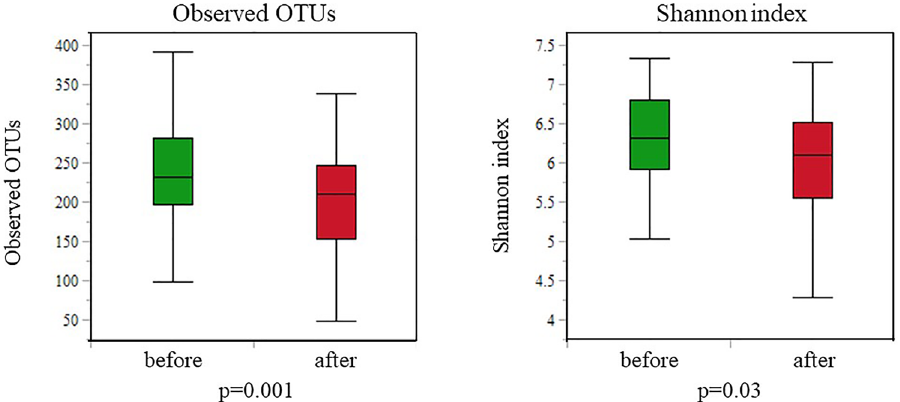
Figure 4. Alpha diversity of the gastric microbiota before and after distal gastrectomy (DG). Comparisons of the operational taxonomic unit and Shannon indices of the gastric microbiota before and after DG. P-values from the Kruskal–Wallis test are